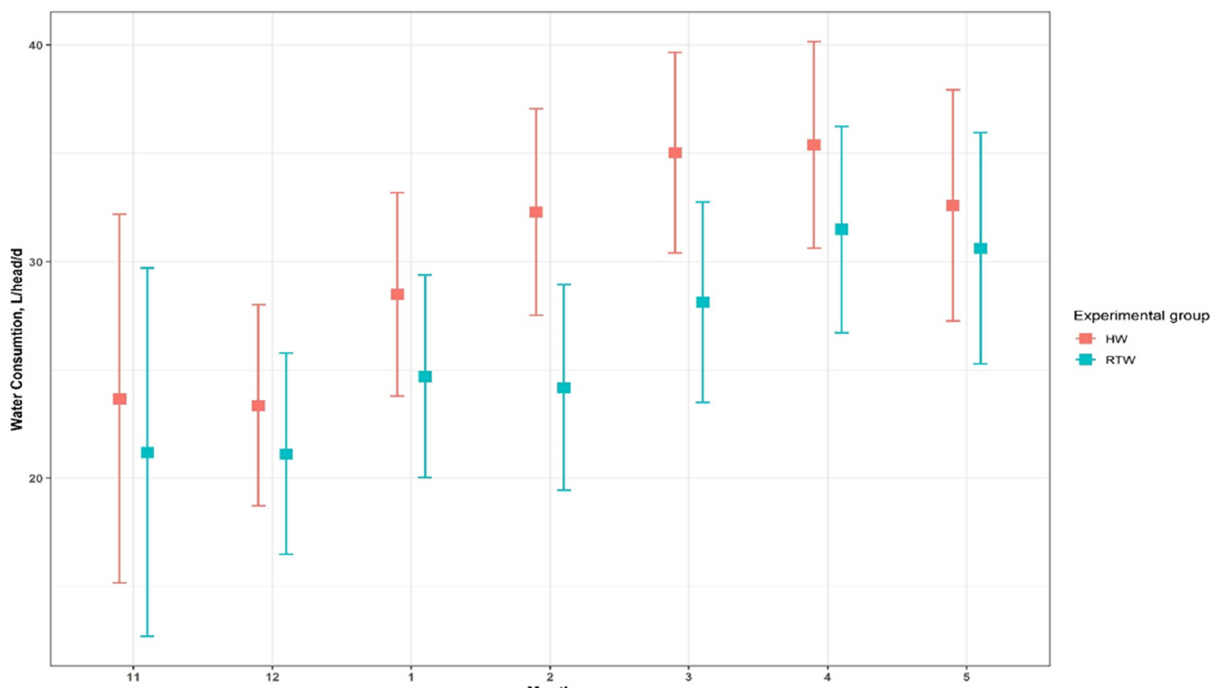
Figure 2. Trends in individual water consumption (L/head/d) during the trial in HW and RTW groups .